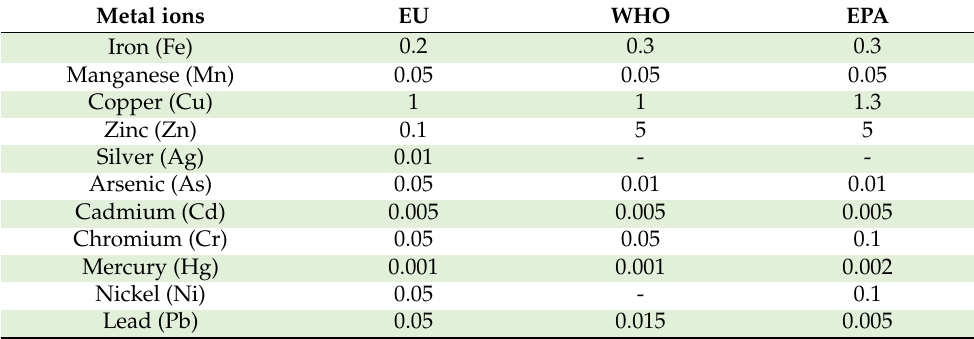
Table 2. European limit values [41] for heavy metal concentration in comparison with WHO [42] and EPA* [43] values (all expressed in